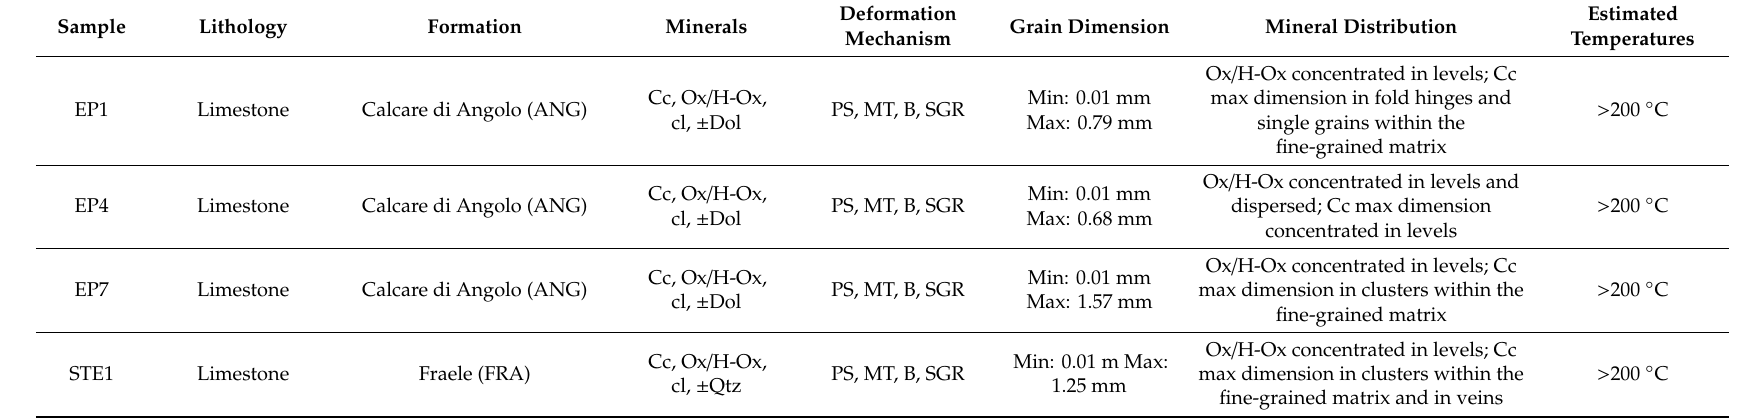
Table 1. Microstructural analysis results (Cc: calcite; Dol: dolomite; Qtz: quartz; Ox / H-Ox: oxi / hydroxides; cl: clay minerals; PS: pressure solution; B: bulging recrystallization; MT: mechanical twinning; and SGR: sub-grain